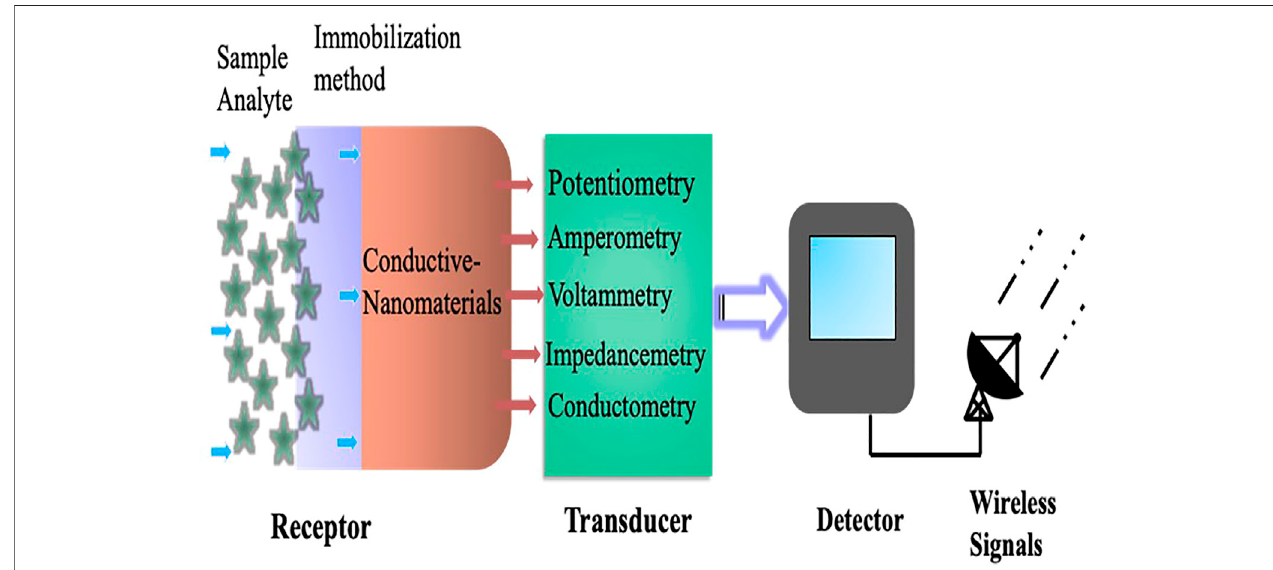
FIGURE 1 | A schematic representation of the basic design principle and key components of an electrochemical biosensor.